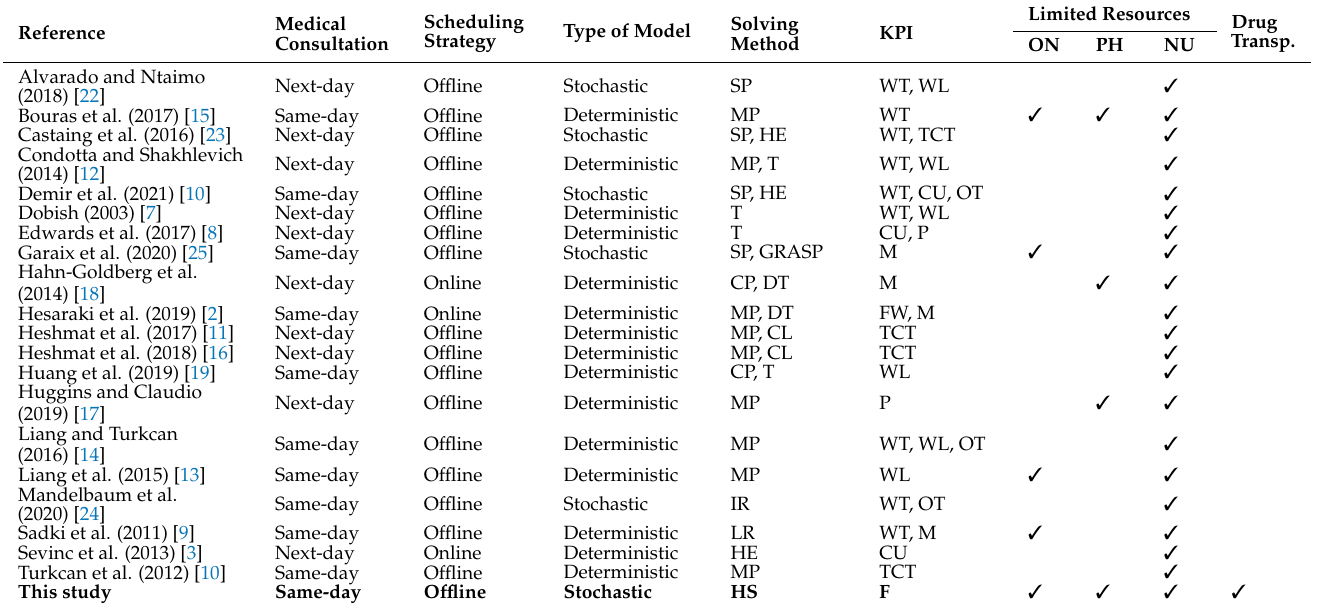
Table 1. Comparison with the